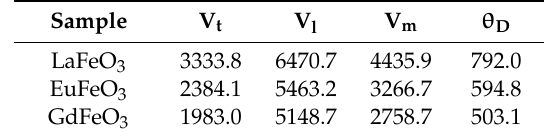
Table 4. Values of shear velocity (V t ), compressional velocity (V l ), sound velocity (V m ), and the Debye Temperature ( θ D ) of RFeO 3 (R = La, Eu, Gd) compounds.